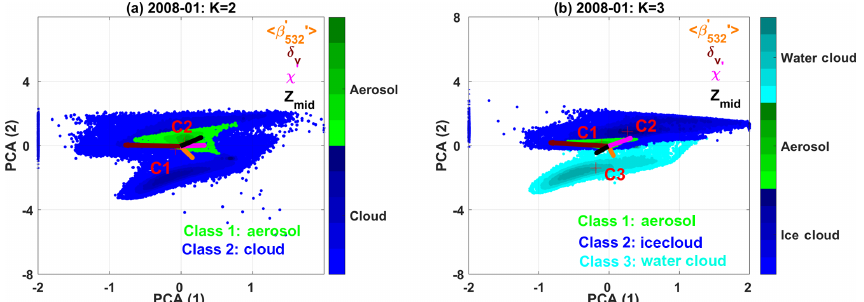
Figure 12. Principle component analysis of the FKM classifications for the January 2008 test data. PCA results for the two-class CAD FKM classifications are shown on the left (a) , and the three-class CAD FKM classifications are shown on the right (b) . In both figures, the green points are projections of aerosol data onto the PCA axes with their center located at red crosses labeled C1. Similarly, the blue and cyan ( a only) points are projections of cloud data onto the PCA axes. In panel (a) , the blue points represent all clouds, while in panel (b) the blue points represent ice clouds and the cyan points represent water clouds. Higher sample number condensations are in darker colors, while lower condensations are in lighter colors. Also shown in both panels are color-coded vectors representing each of the classification variables: (cid:105) , in orange), depolarization ratio ( δ v , in brown), color ratio ( χ (cid:48) , in magenta), and altitude ( z backscatter intensity ( (cid:104) β (cid:48) mid , in olive). The 532 projections of the variable vectors along the principal component axes indicate the degree to which each variable contributes to PCA1 and PCA2. Variable vectors that are parallel to either PCA1 or PCA2 contribute essential information to that component, while vectors that are perpendicular do not contribute at